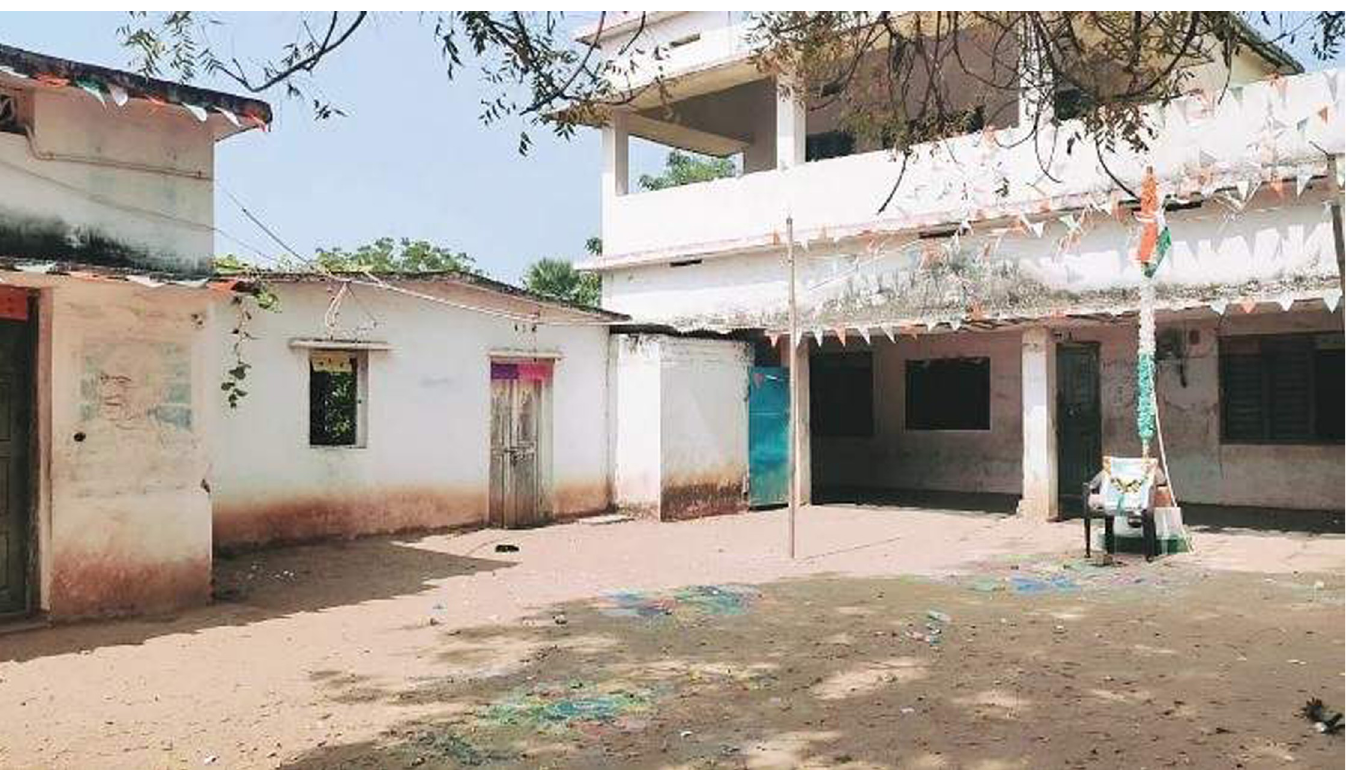
Fig 2. Picture of a household in Diourbel